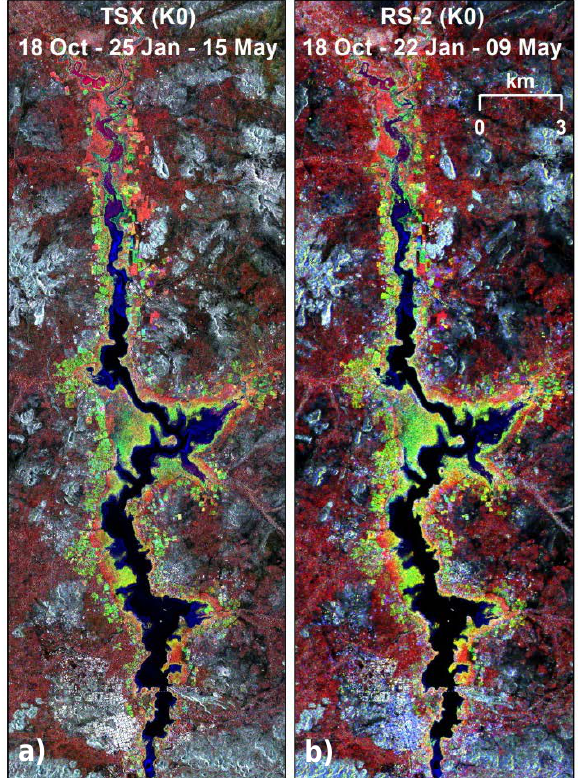
Figure 6. Multitemporal red-green-blue (RGB) stack of K 0 for (a) TerraSAR X: 18 Oct. 2014, 25 Jan. 2015, 15 May 2015; and (b) RADARSAT-2: 18 Oct. 2014, 22 Jan. 2015, 09 May 2015 Figure 7. Multitemporal classification results for (a) TerraSAR-